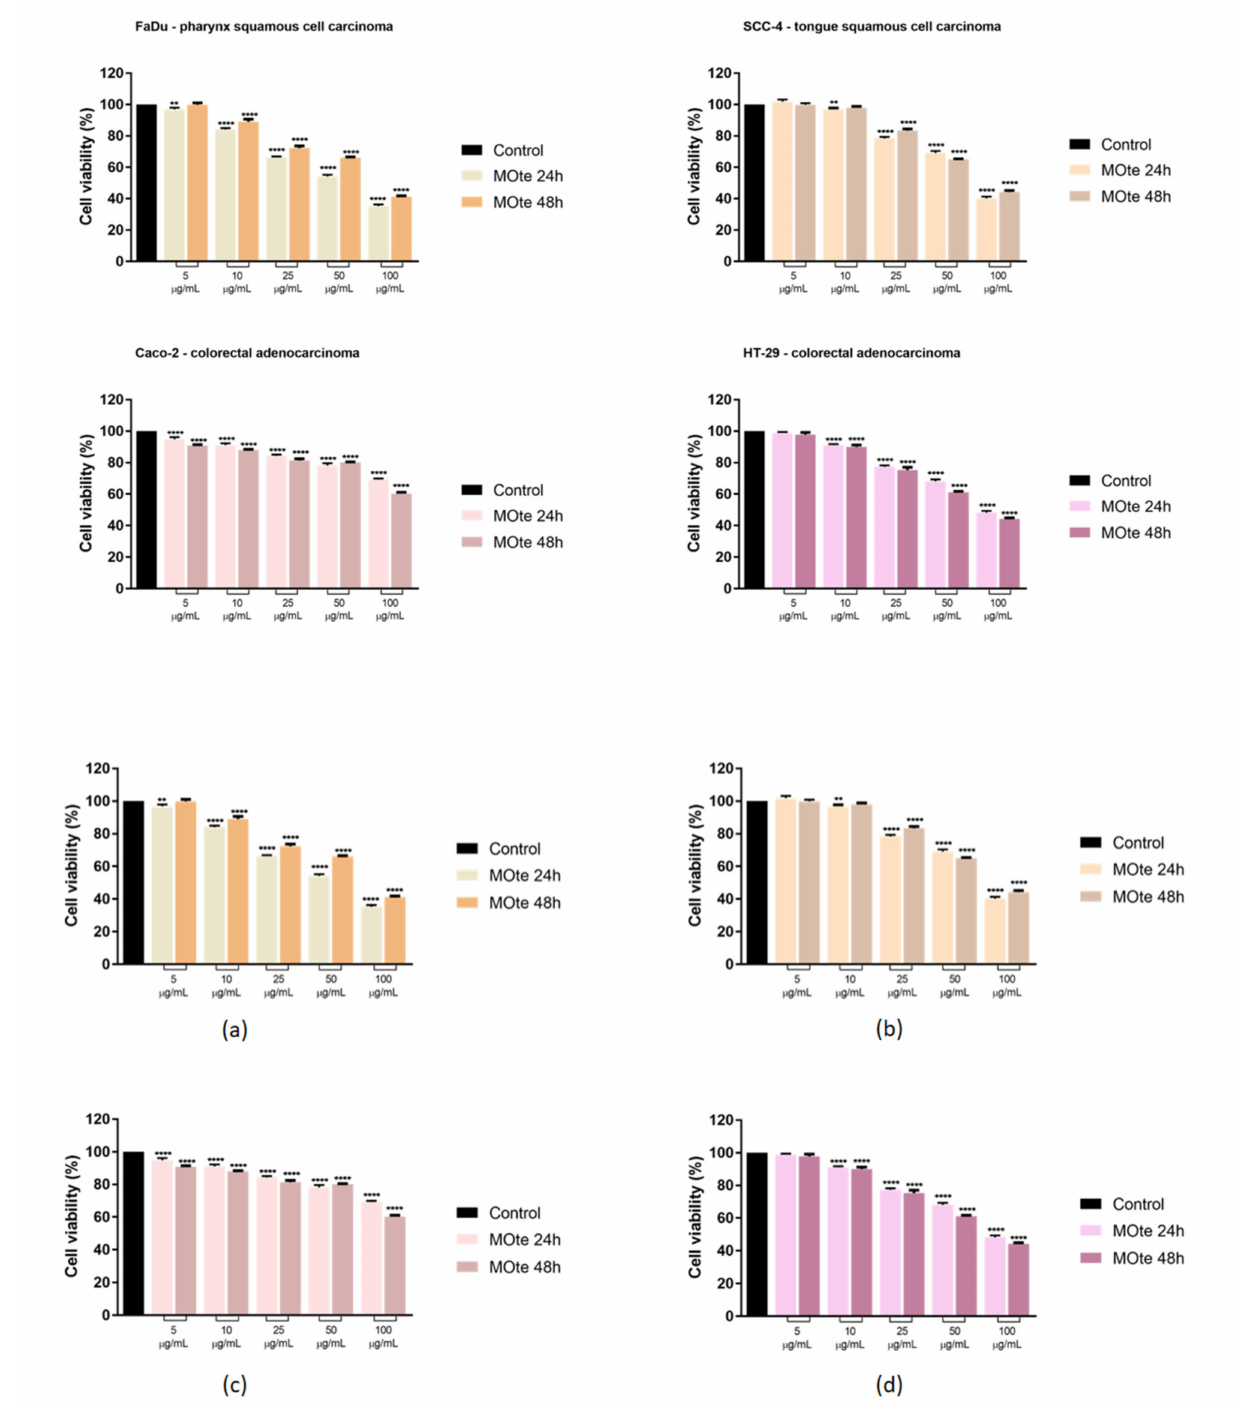
Figure 4. Cell viability assessment of Melissa officinalis total extract (MOte) (5, 10, 25, 50 and 100 µ g/mL) in: ( a ) FaDu— pharynx squamous cell carcinoma; ( b ) SCC-4—tongue squamous cell carcinoma; ( c ) Caco-2—colorectal adenocarcinoma and ( d ) HT-29—colorectal adenocarcinoma at 24 and 48 h post-stimulation by Alamar blue assay. The results are expressed as cell viability percentage (%) normalized to control (untreated cells). The data represent the mean values ± SD of three independent experiments performed in triplicate. One-way ANOVA analysis was applied to determine the statistical differences in rapport with control cells followed by Tukey post-test (** p < 0.01 and **** p <